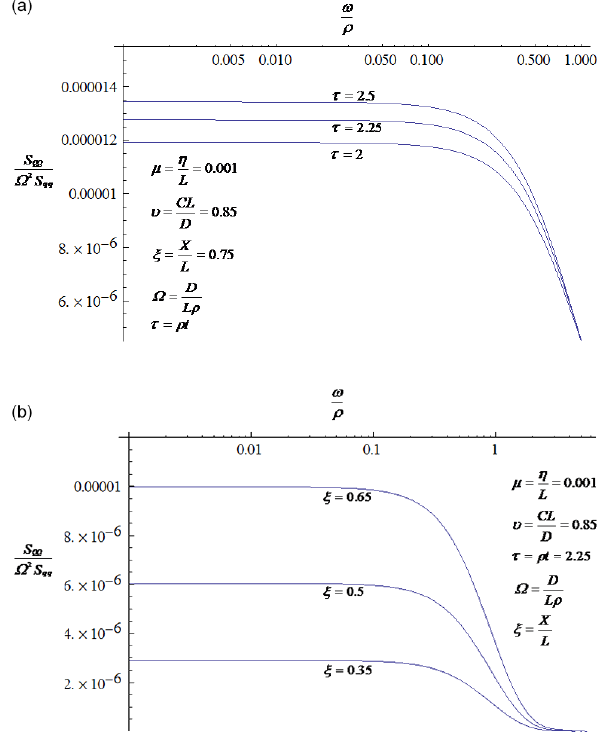
Figure 1. Dimensionless evolutionary power spectral density as a function of dimensionless frequency for various (a) time scales and (b) locations.